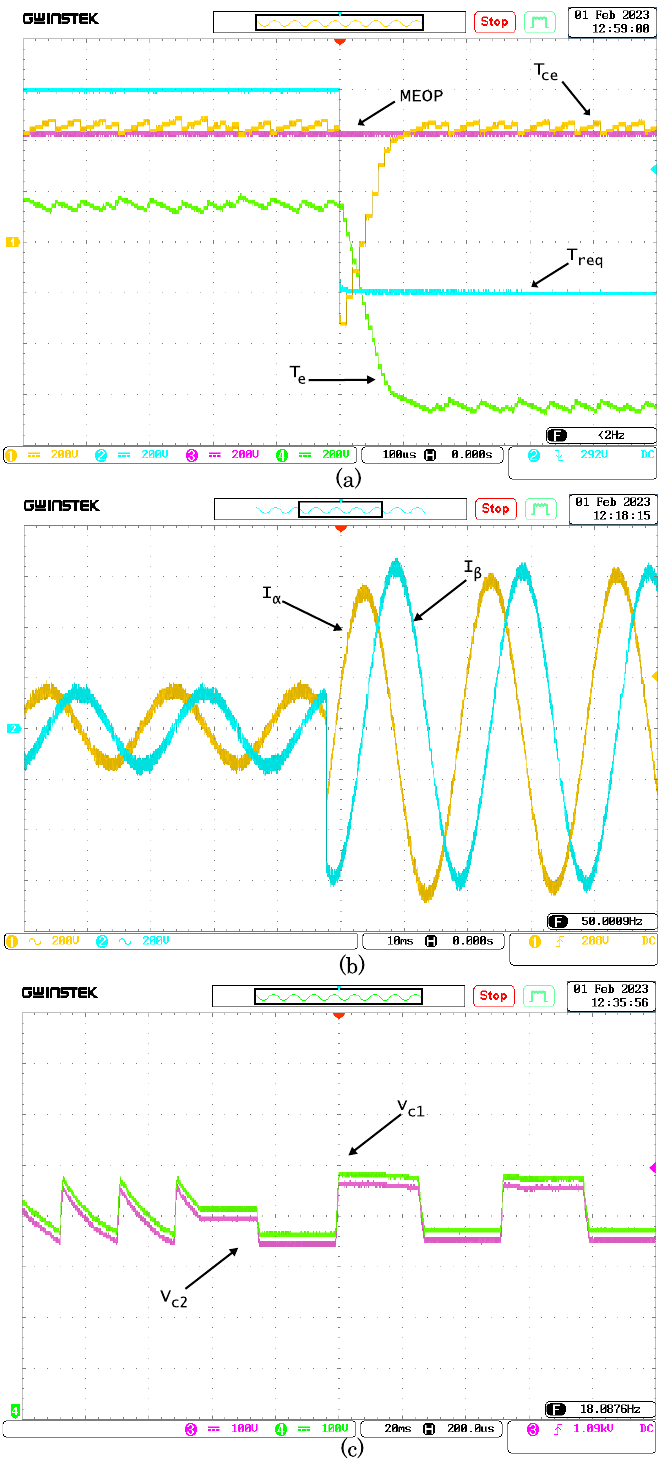
Figure 17. HIL dynamic response against step down high torque demand. ( a ) Torques at the drivetrain. ( b ) α − β Currents. ( c ) dc-Link